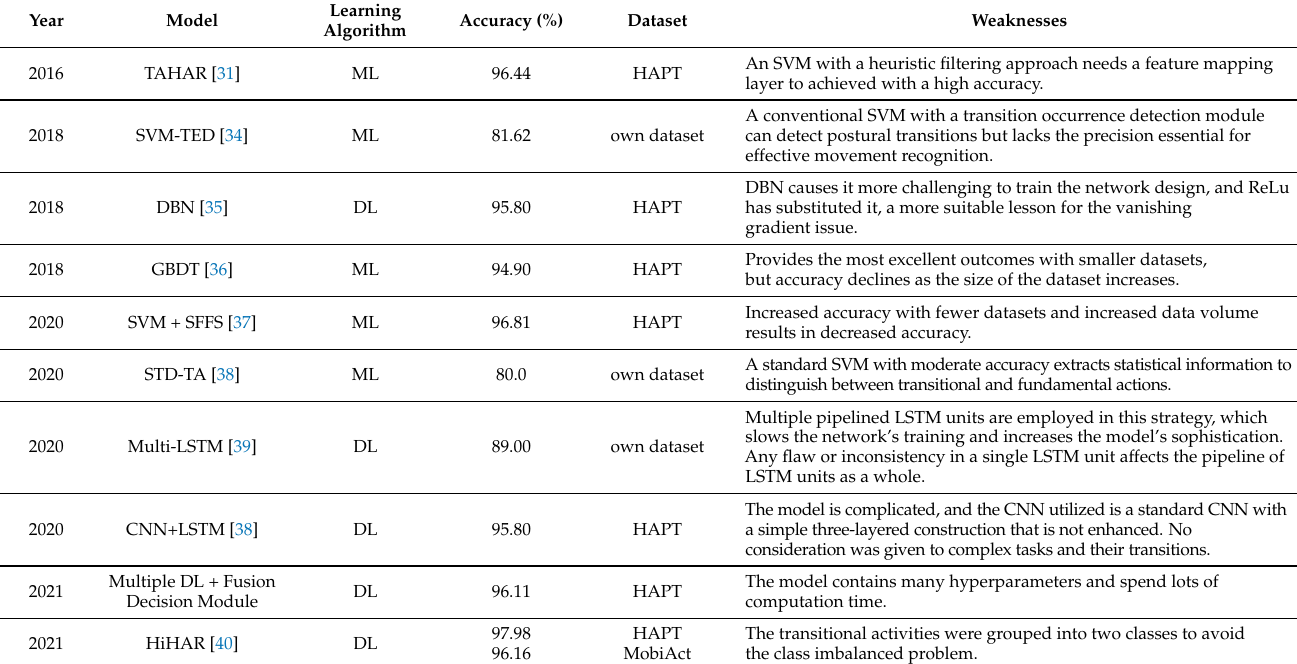
Table 1. A summary of the related